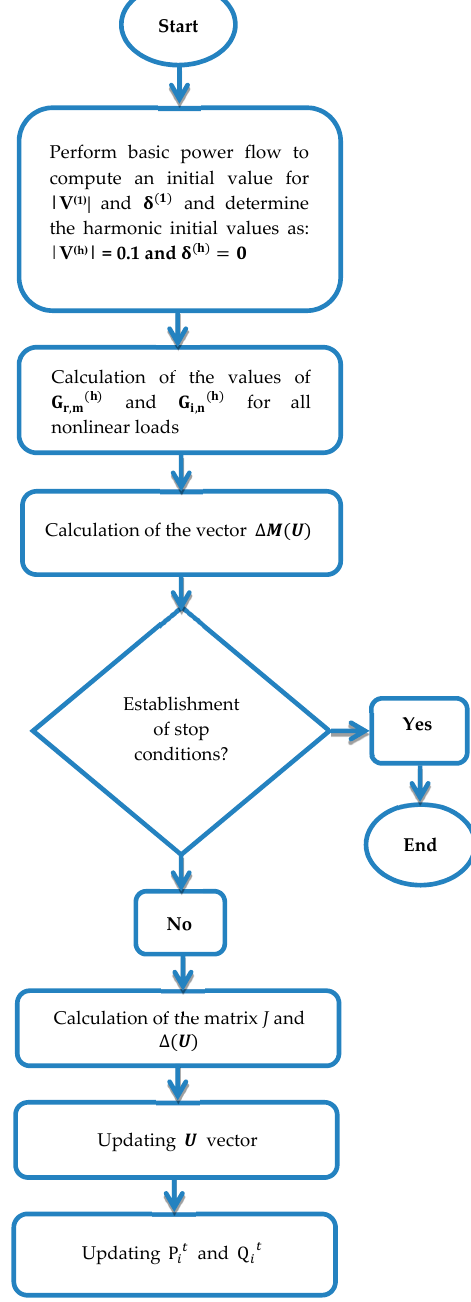
Figure 1. Flowchart of Newton–Raphson harmonic power flow algorithm [18,19].